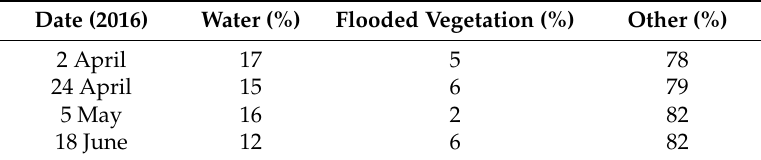
Table 3. Percentages of each class identified for each H-Alpha–Wishart model through time.